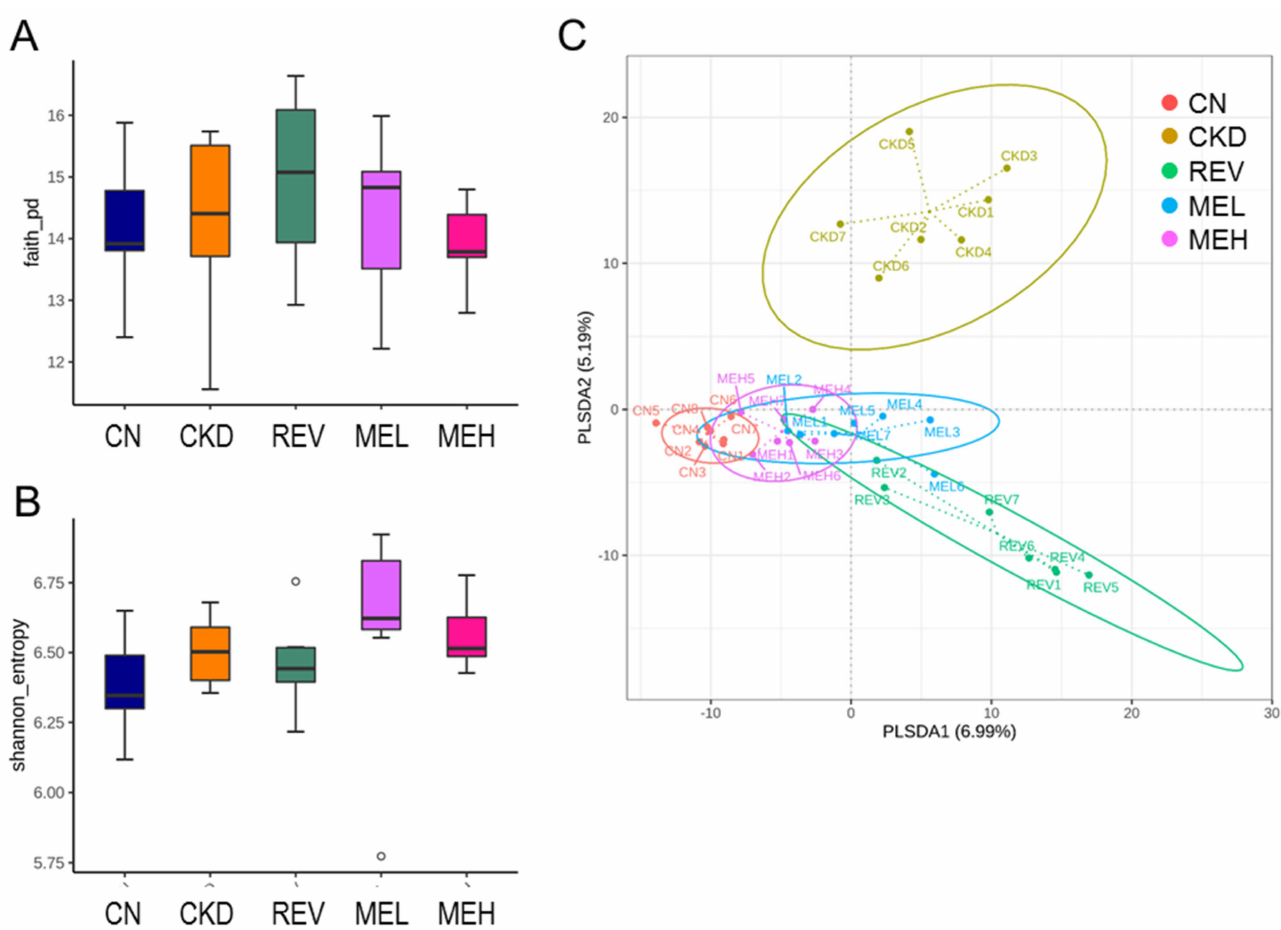
Figure 4. Gut microbiota communities in five experimental groups. ( A ) Faith’s phylogenetic diversity (PD) index and ( B ) the Shannon index were applied to analyze α -diversity. ( C ) β -Diversity analysis was assessed via partial least squares discriminant analysis (PLSDA) in five clusters, whereby each dot represents the microbiota of a single sample, and the color of the dot indicates the group and the sample. Each axis percentage reflects how much variation was accounted for by the